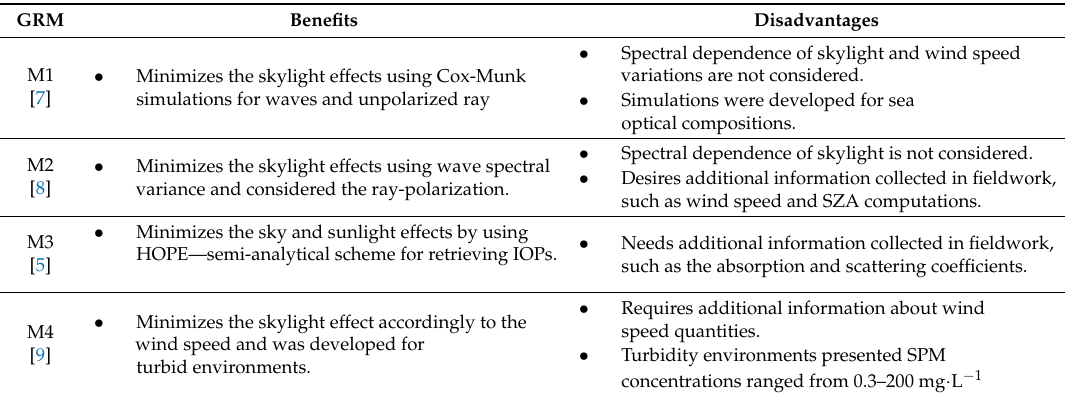
Table 2. Features of tested glint removal methods